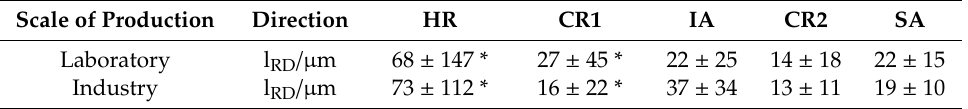
Table 4. Microstructural parameter for laboratory and industrially produced EN AW-6016 sheets. Scale of Production Direction HR CR1 IA CR2 SA Laboratory l RD / µ m 68 ± 147 * 27 ± 45 * 22 ± 25 14 ± 18 22 ± 15 Industry l RD / µ m 73 ± 112 * 16 ± 22 * 37 ±